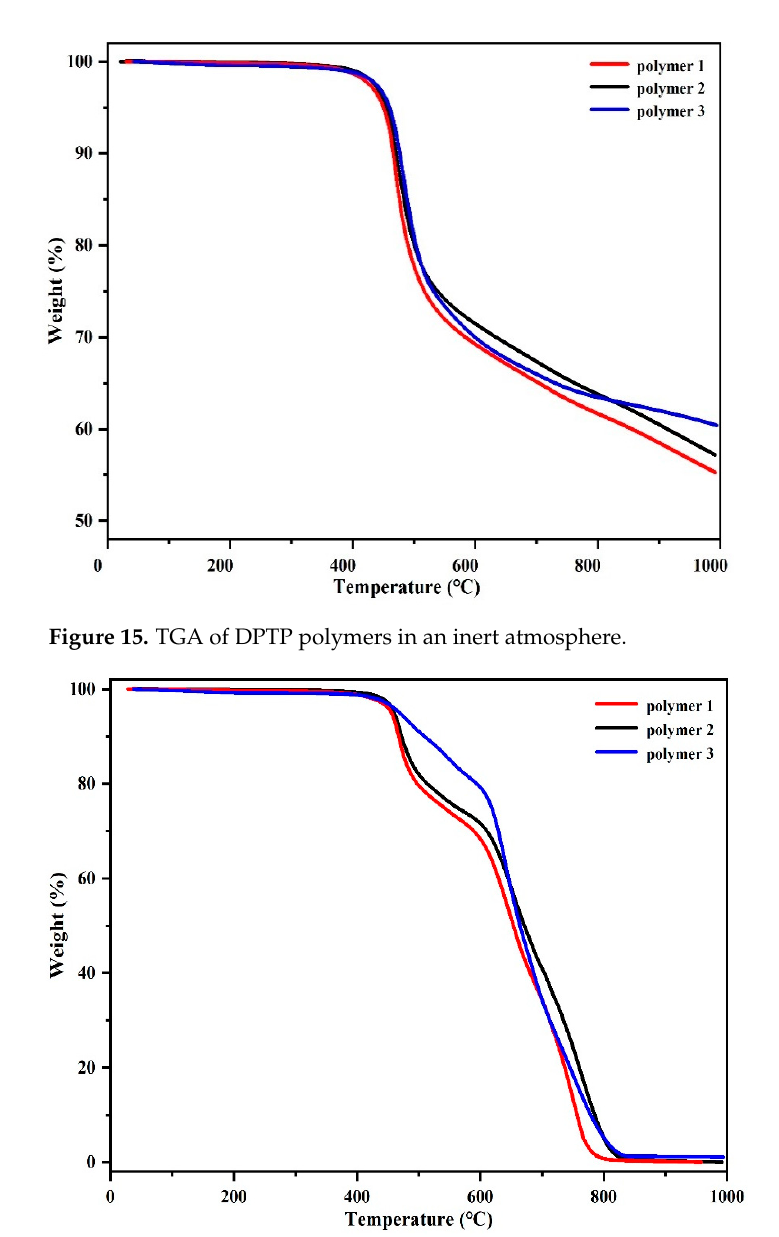
Figure 16. TGA of DPTP polymers in an air atmosphere. Table 4. Thermal parameters of DPTP polymers in inert and air atmospheres. In Nitrogen